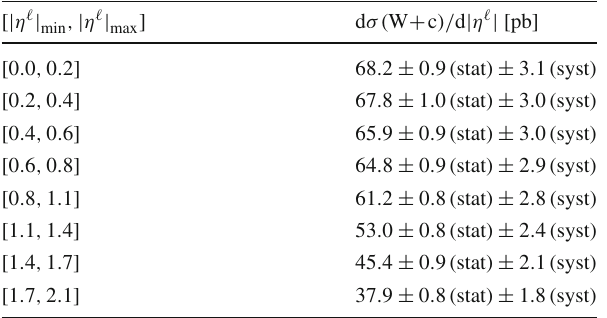
Table 7 Measured differential cross section as a function of | η (cid:3) | , d σ( W + c )/ d | η (cid:3) | from the combination of all four channels